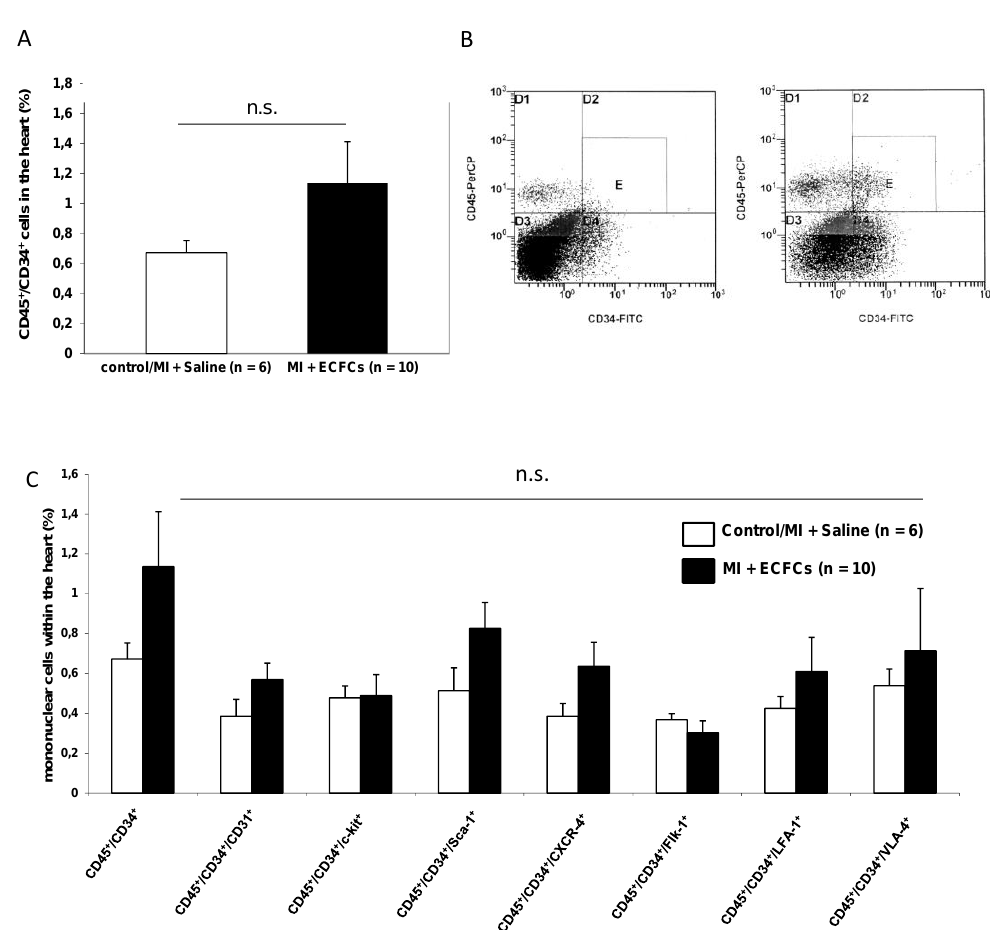
Figure 4. No enhanced homing of bone marrow (BM)-derived progenitor cells after human ECFC injection into ischemic myocardium. ( A ) Bar graphs representing the percentage of CD45 + / CD34 + stem cells in the ischemic hearts of control animals (white bar) and after ECFC transplantation (black bar) 2 days after MI. Data represent mean ± SEM; n.s., not significant. ( B ) Representative flow cytometry (FACS) analyses of CD45 + / CD34 + cells in the heart of control animals (left) and after ECFC transplantation (right) 2 days after MI. ( C ) Bar graphs representing the percentage of CD45 + / CD34 + subpopulations in the ischemic hearts of control animals (white bars) and after ECFC transplantation (black bars) 2 days after MI. Data represent mean ± SEM;n.s., not significant.